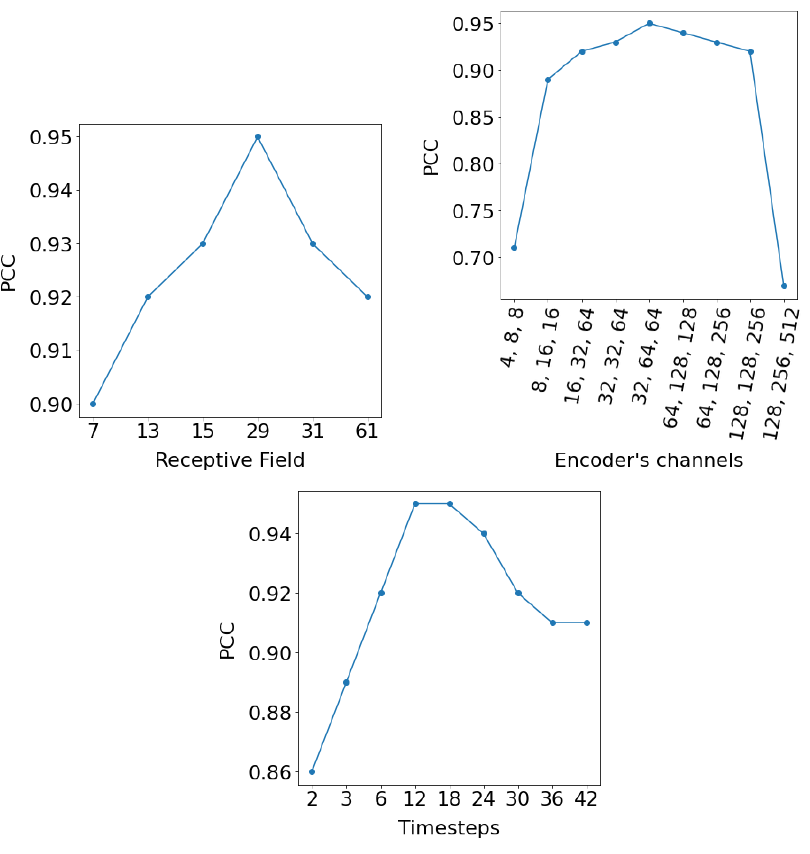
Figure 7. PCC as a function of the receptive field ( top left ), the number of filters in each of the 2D convolutional layers at the encoder part ( top right ), and the hyperparameter timesteps ( bottom